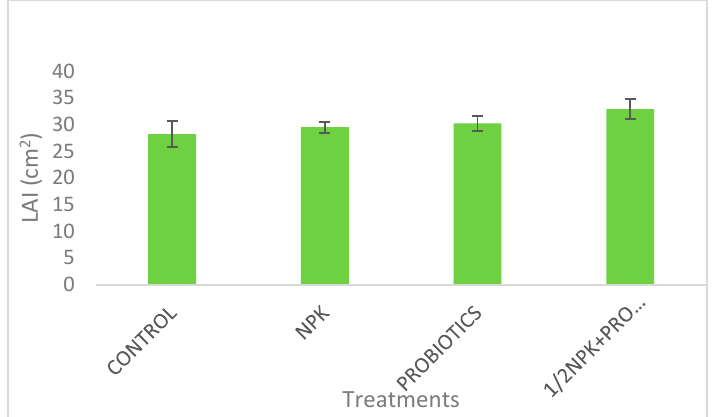
Figure 3. Leaf area index of the peanut plants.